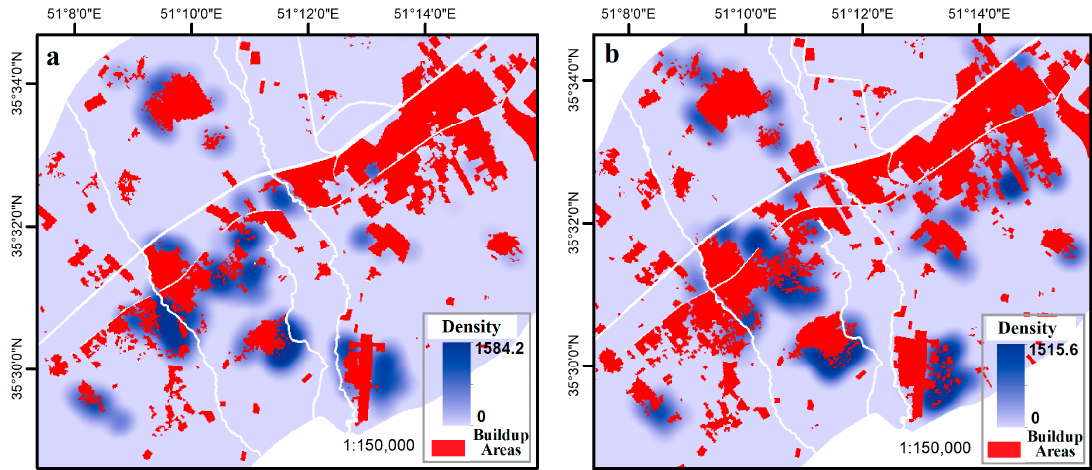
Figure 12. Density maps of urban development produced by the KDF for the periods of 1992–1996 and 1996–2002.